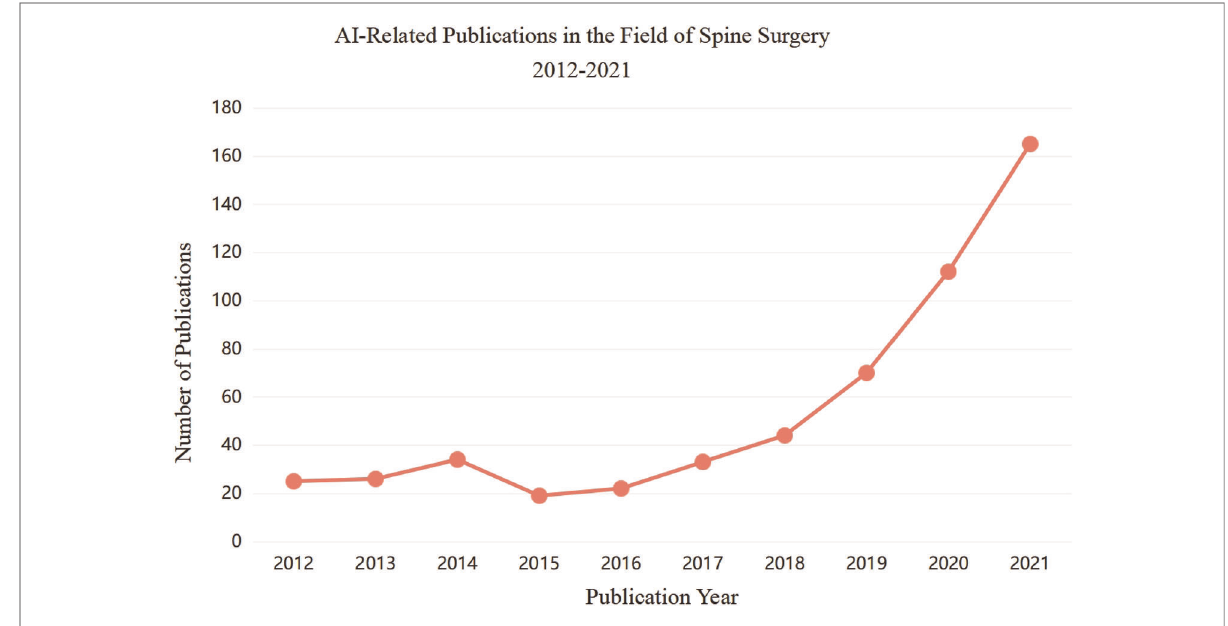
FIGURE 1 AI-related publications in the fi eld of spine surgery 2012 –